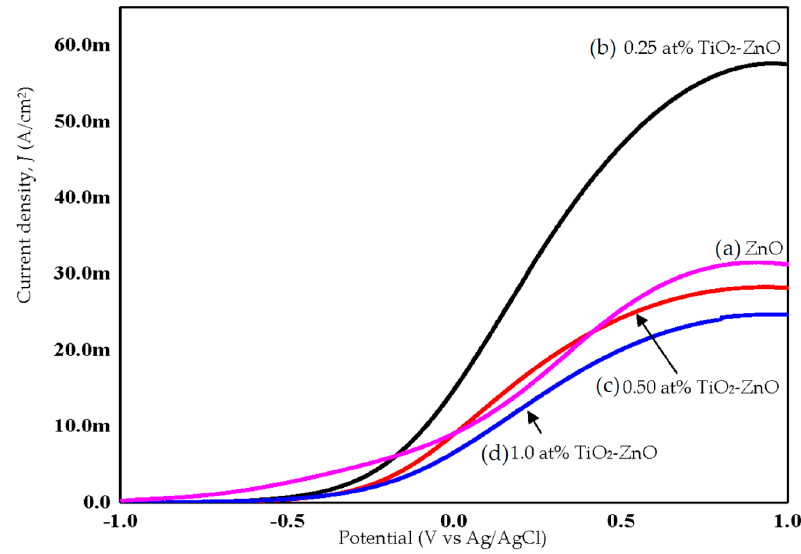
Figure 11. Photocurrent response of ( a ) ZnO; ( b ) 0.25 at % TiO 2 -ZnO; ( c ) 0.50 at % TiO 2 -ZnO; and ( d ) 1.0 at % TiO 2 -ZnO under solar illumination.